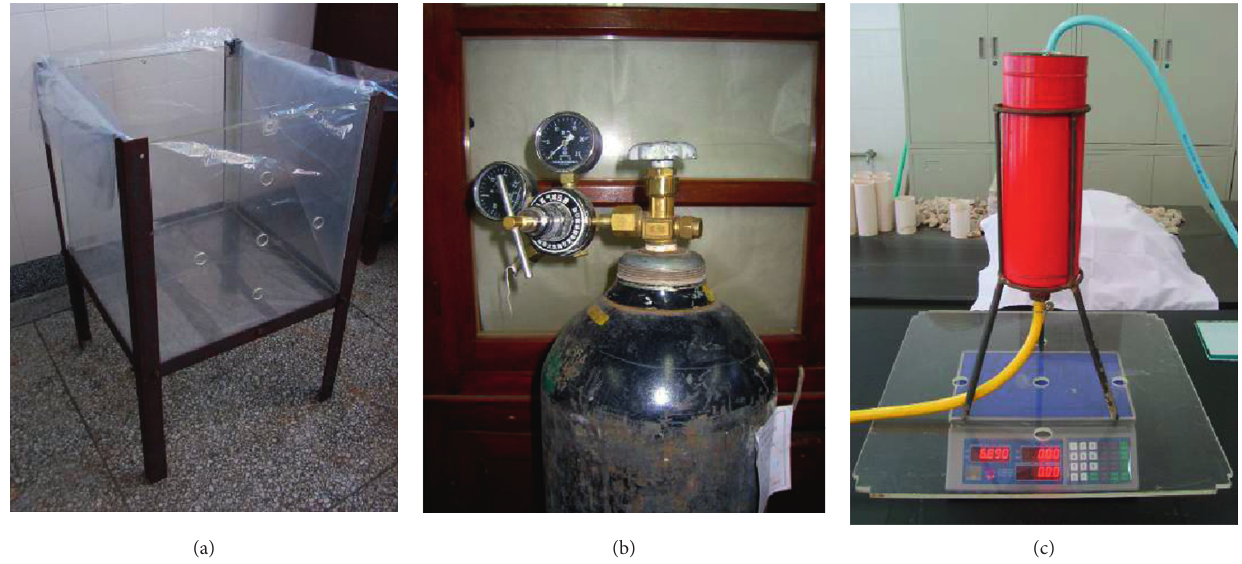
Figure 3: Physical photos of grouting experiments device. (a) Experiment chamber. (b) Pressure supply device. (c) Grout storage